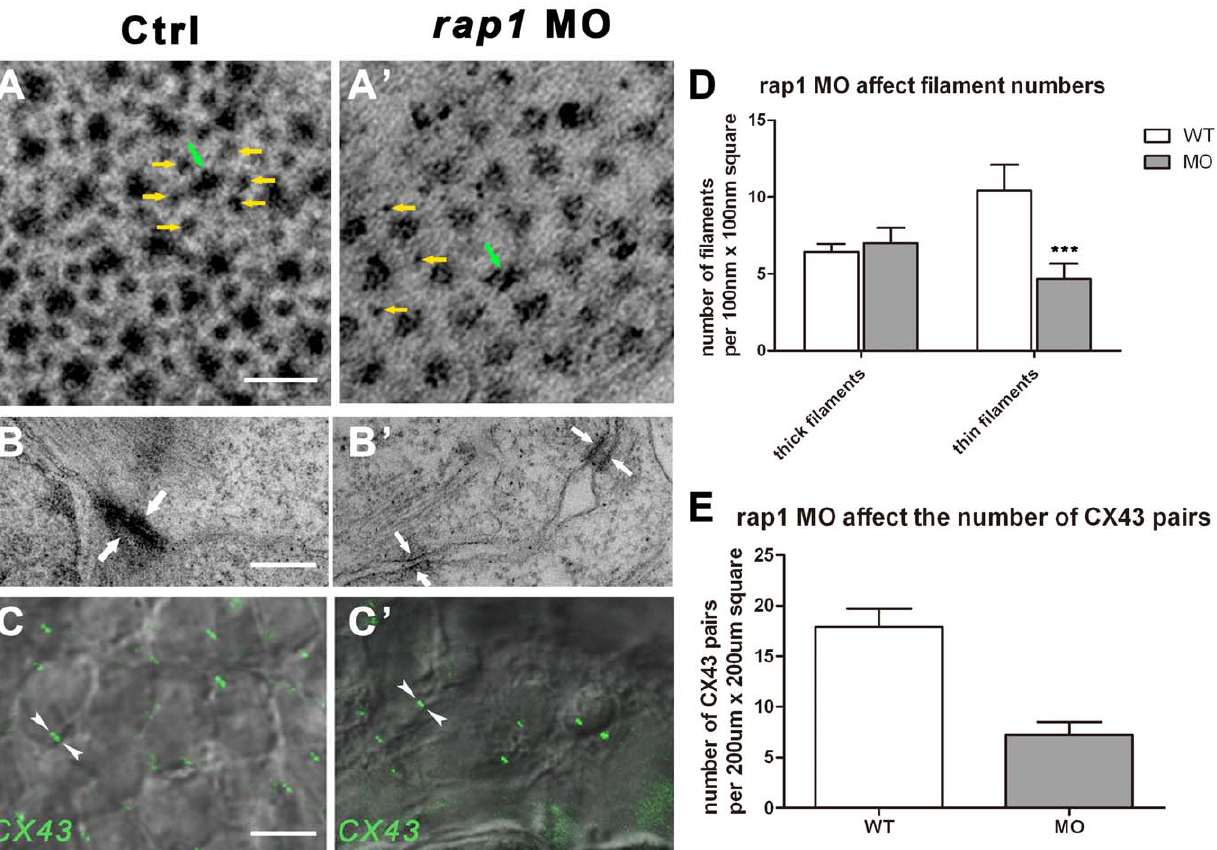
Figure 3. Ultra-structural changes of cell junctions and sarcomeres in Rap1 knock-down zebrafish heart. Transmission electronic scan revealed that the myofibril units, regularly organized into hexagonal lattices with thick (green arrow) and thin (yellow arrows) filaments (A) with adherens junctions (AJs) along the membrane of adjacent cardiac myocytes (B). In rap1 MO heart, thick filaments (green arrow) number was not markablely changed but thin filaments (yellow arrows) number was significantly and statistically reduced (A’ and D), and less myofibrils attached to AJs (arrows in B and B’), with lager space between the membrane of adjacent cardiac myocytes (B’). Antibody against Connexin 43 stained a significantly and statistically less GJ signal (arrowheads in C and C’) in rap1 MO cardiomyocytes at 3 dpf, compared to a normal heart (C, C’, and E). Scale bar, 50 nm in A and A’; 350 nm in B and B’; 50 m m in C and C’. Columns and error bars in D and E showed mean 6 S.D. n=9 in filaments experiment (D) for each group, and n=10 in C 6 43 antibody staining experiment (E) for each group. Unpaired two-tailed t-test was used to test the significance between two columns in each group in D. *** in statistic graph represent p , 0.001 in the t-test.